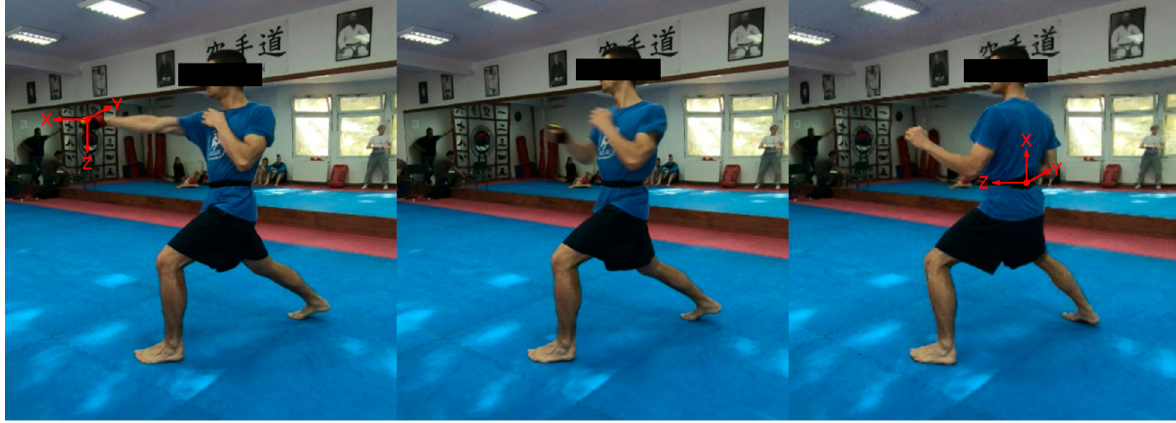
Figure 2. The movement start, transition, and end position with the positioning of the IMU and orientation of the sensor axes.